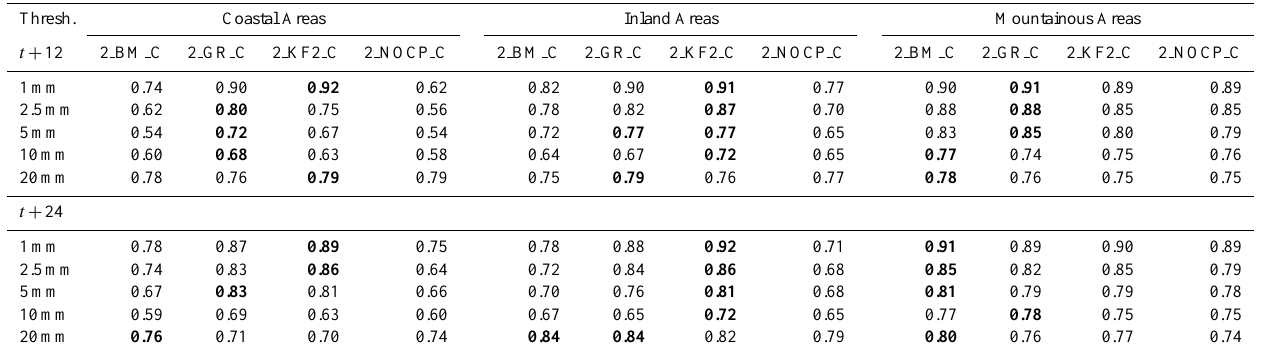
Table 11. As in Table 10 but for Proportion Correct (PC) score (0–1). Thresh. Coastal Areas Inland Areas Mountainous Areas